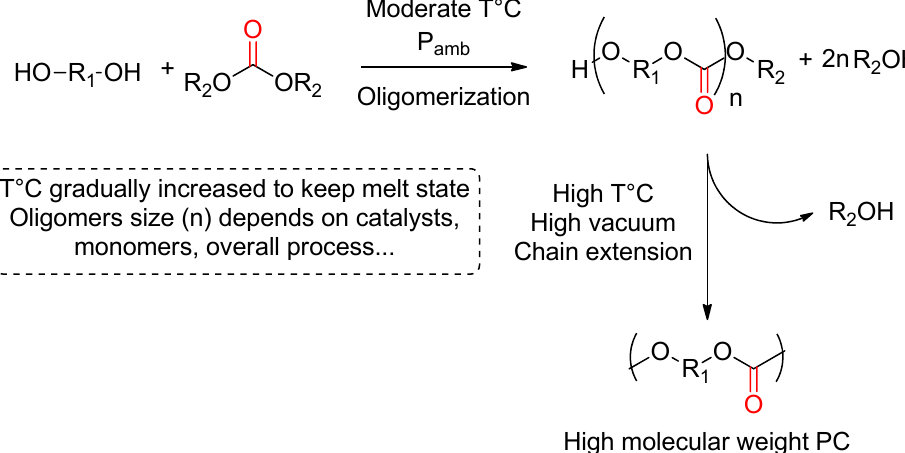
Scheme 29. Schematic representation of polycarbonate synthesis via melt polycondensation of diols with DPC or DMC (R 2 = CH 3 or C 6 H 5 ).